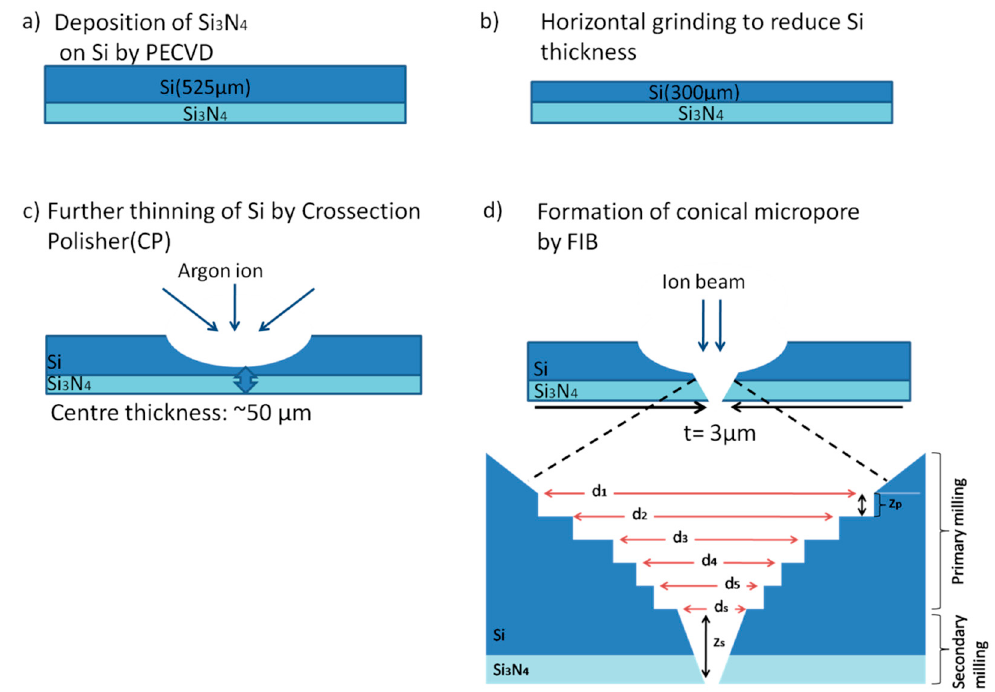
Figure 1. Fabrication process of the conical-shaped Si micropore structure, ( a ) deposition of Si 3 N 4 on Si, ( b ) horizontal grinding of Si, ( c ) thinning of Si, and ( d ) milling of substrate.